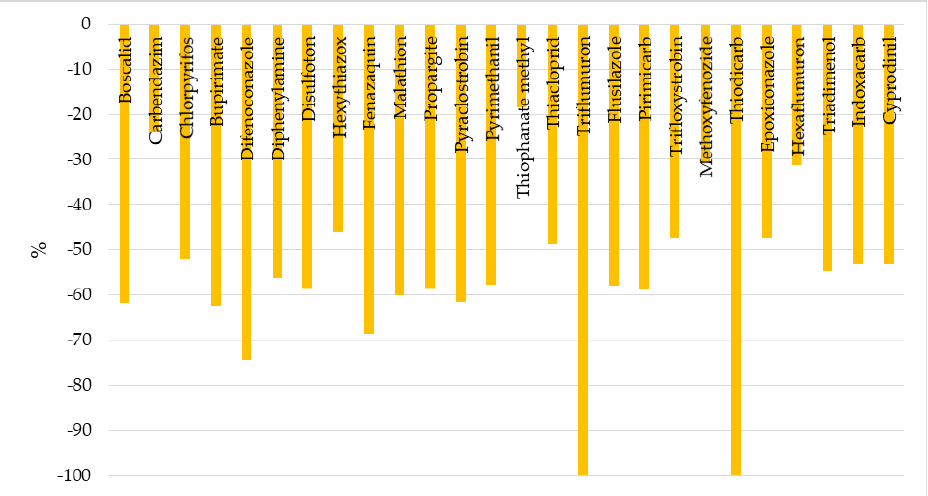
Figure 11. Percentage reduction in pesticide residues in apples as a result of peeling in 2012.